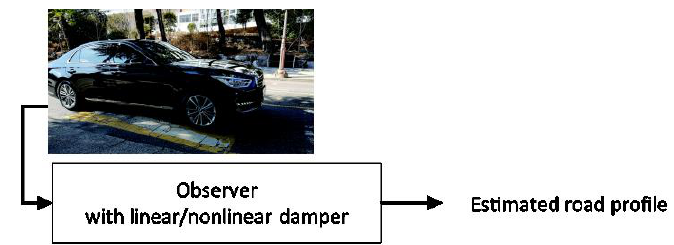
Figure 6. Experimental test of longitudinal road profile estimation.